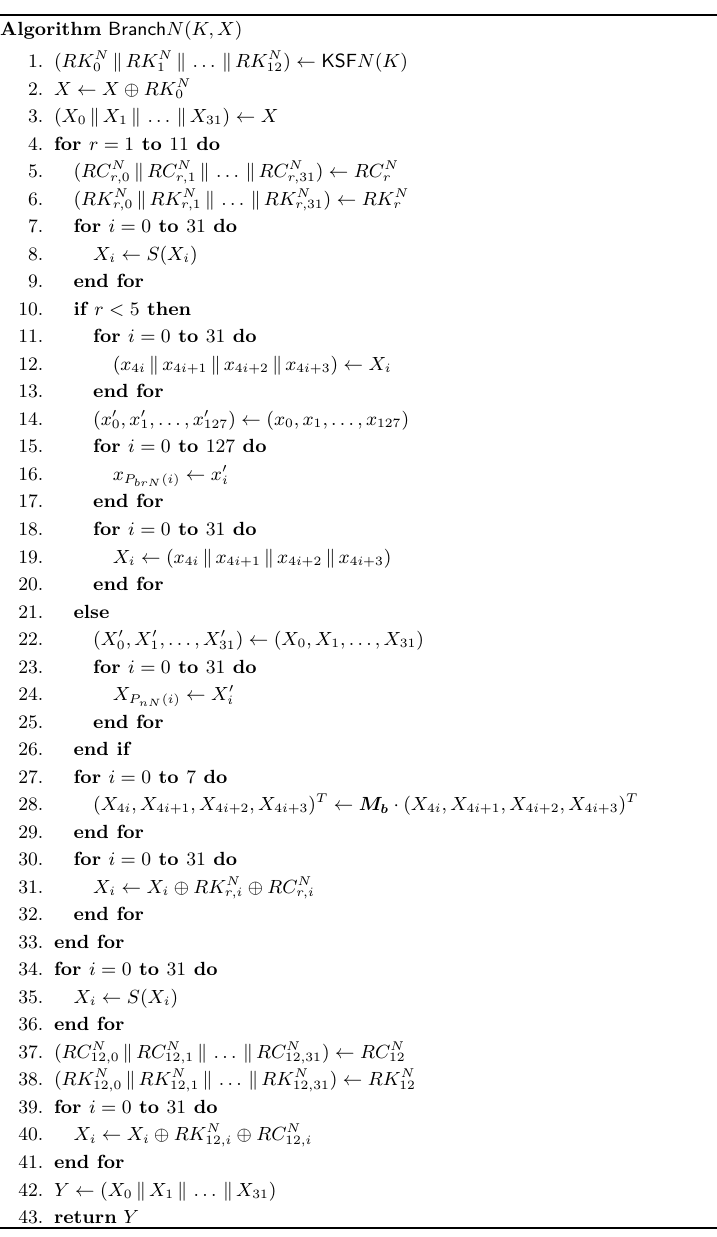
Figure 5: Algorithms of Branch1 and Branch2 , where N ∈ { 1 , 2 } . Algorithm Orthros ( K,M )